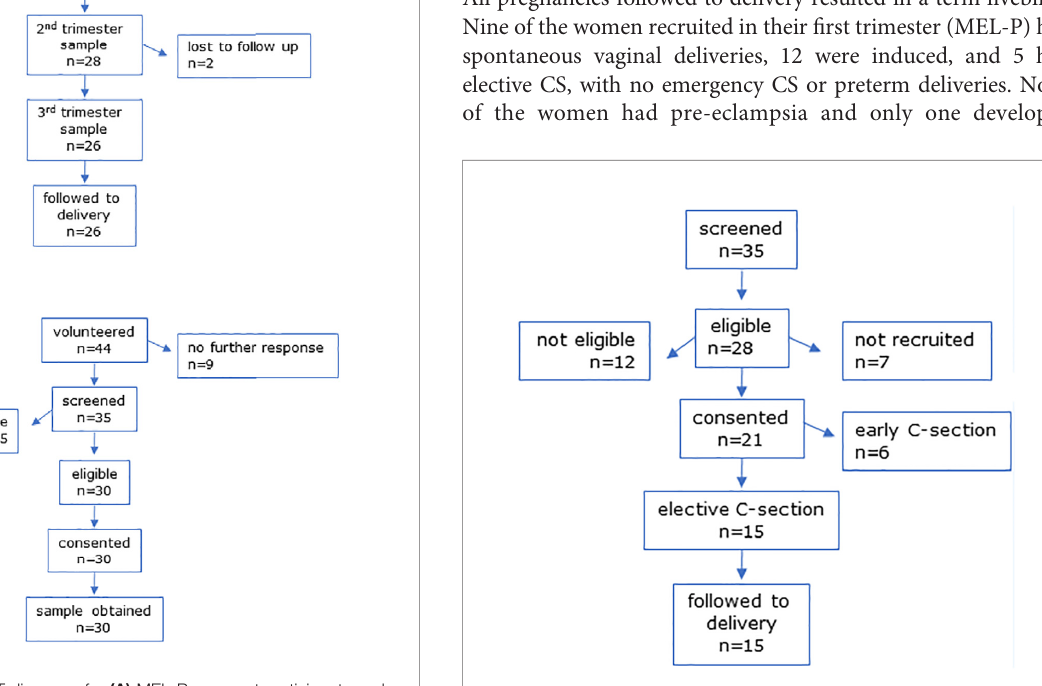
FIGURE 1 | CONSORT diagrams for (A) MEL-P pregnant participants and (B) MEL-P Non-pregnant healthy control subjects. FIGURE 2 | CONSORT diagram for MEL-P2 elective C-section